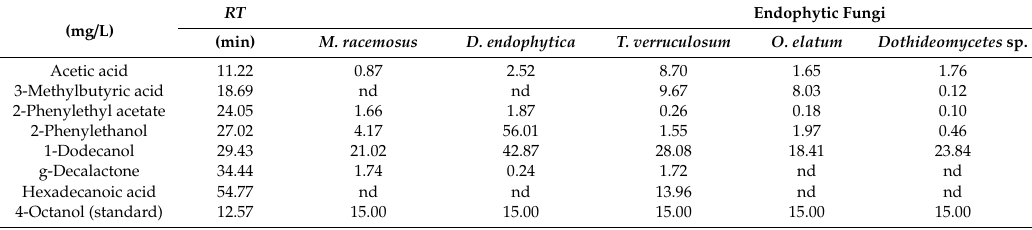
Table 8. Volatile compounds of the endophytic fungi extracts from S. terebinthifolius